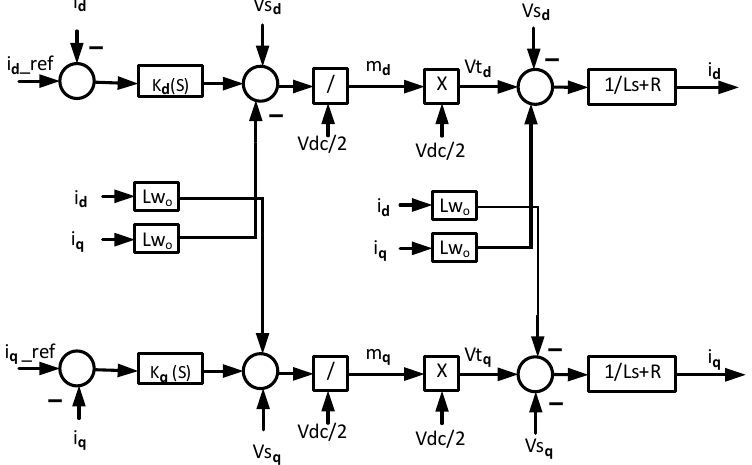
Figure 7. Current control loop in dq frame.